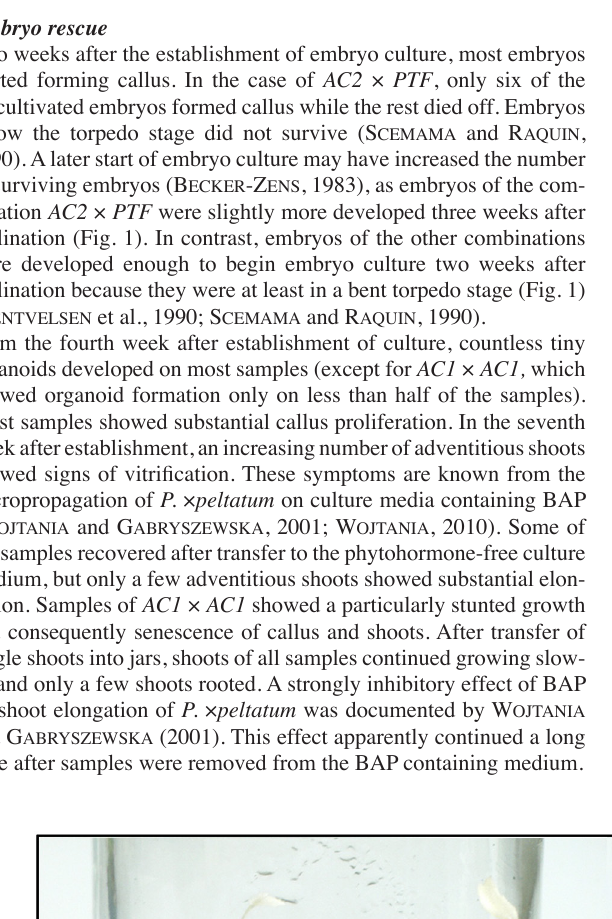
order to achieve hybrids with bluish leaves from the hybridization between P. acetosum and P. × peltatum, a further generation would be necessary, which seems only possible through previous polyploidiza- tion (see above)